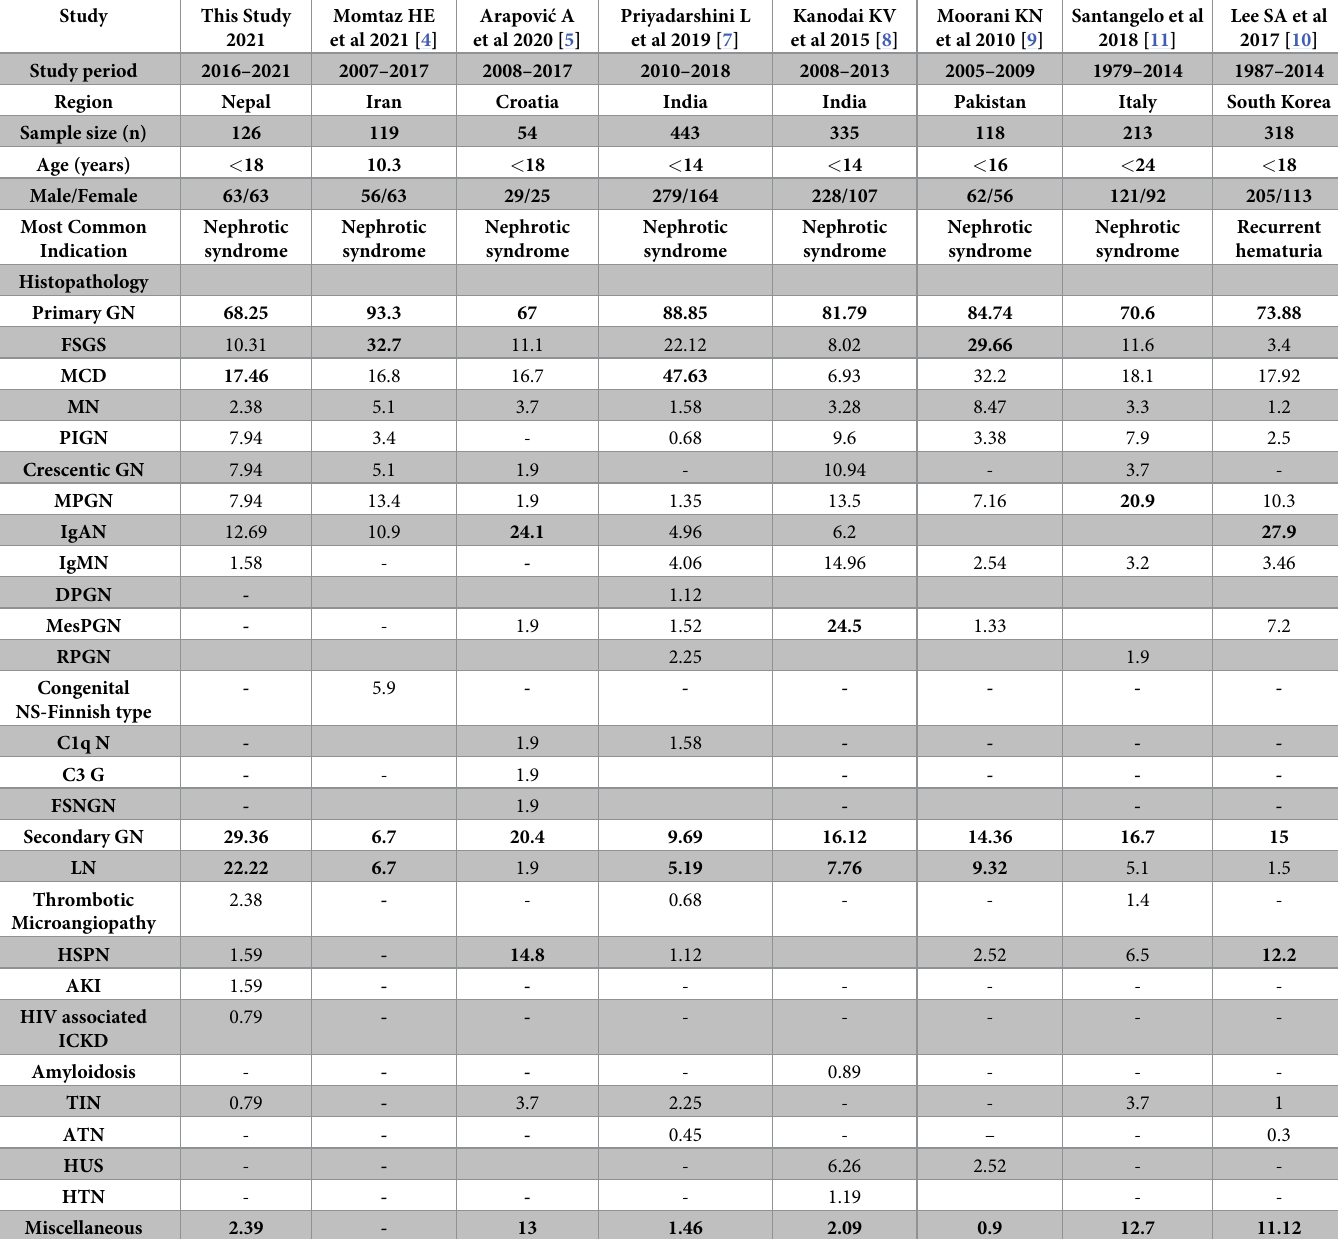
Table 5. Pediatric renal biopsy studies showing demographic details, indications, and histopathological